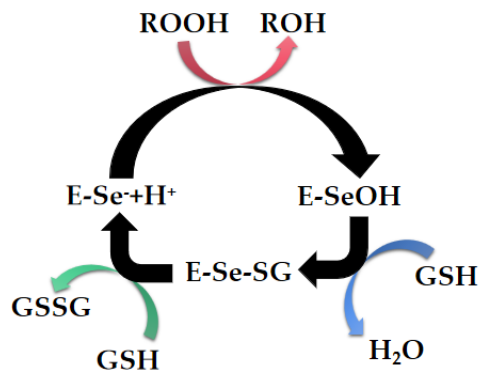
Figure 2. The catalytic cycle of GPx.